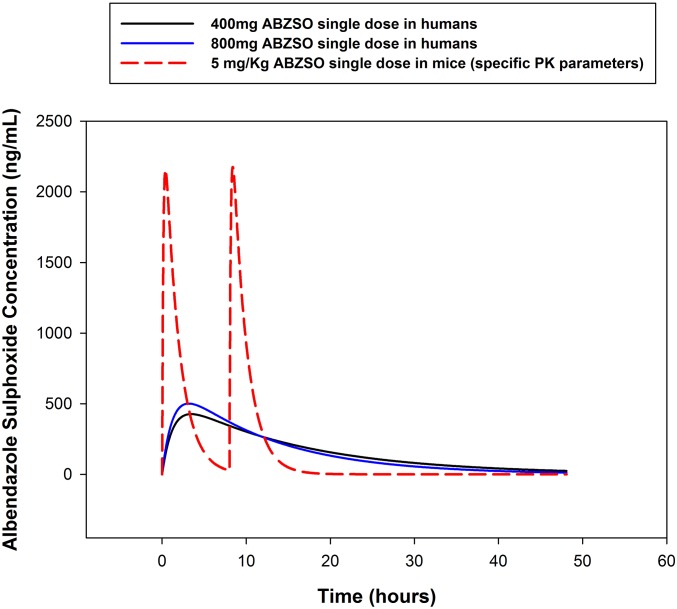
Human equivalent murine dosing regimens were calculated by Monte Carlo simulations.